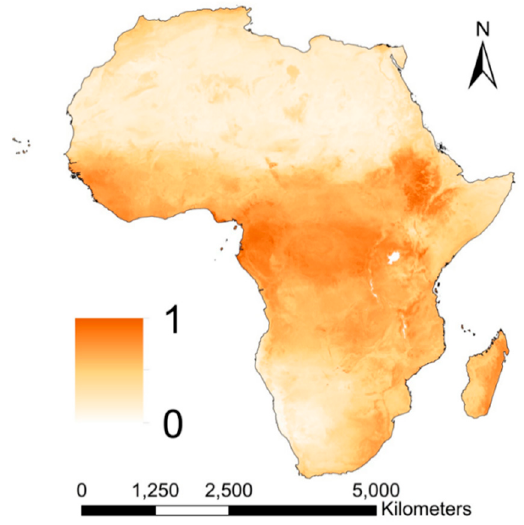
Figure 6. Geospatial variation of the process associated with soil storage and filtering resulting from Equation 7.